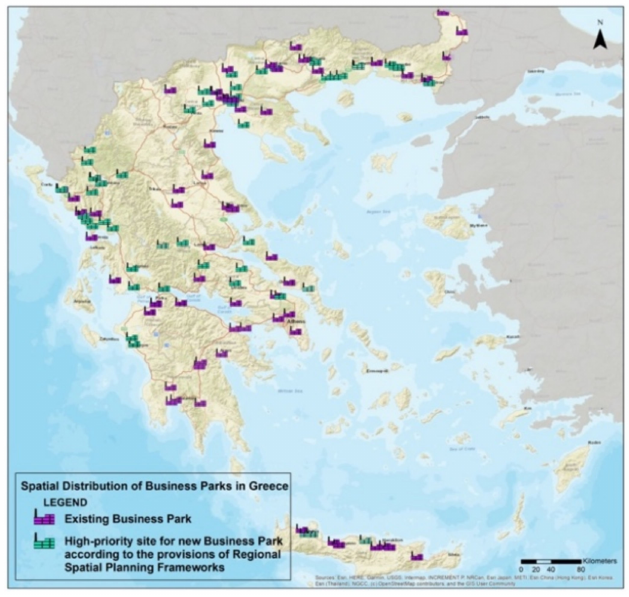
Figure 3. Spatial distribution of business parks in Greece. Source: Own elaboration based on Regional Spatial Planning Frameworks data